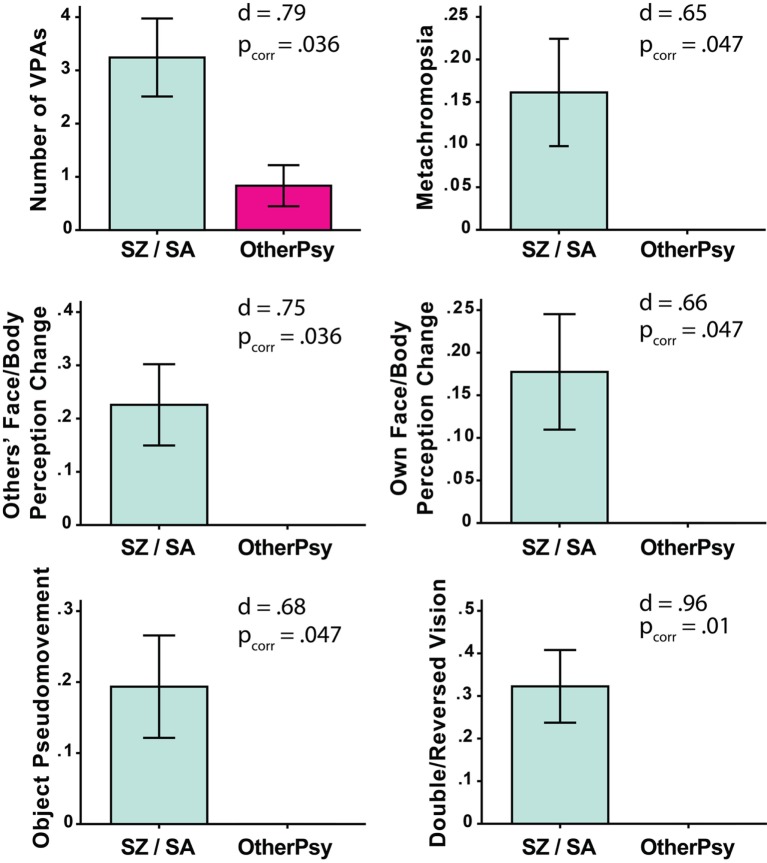
Significant between-group differences on total number of self-reported visual perceptual abnormalities (VPAs) as measured with the Bonn Scale. The schizophrenia/schizoaffective (SZ/SA) group endorsed more VPAs than the group with other psychotic disorders (OtherPsy). The p-values are FDR corrected. Error bars denote ± SEM.